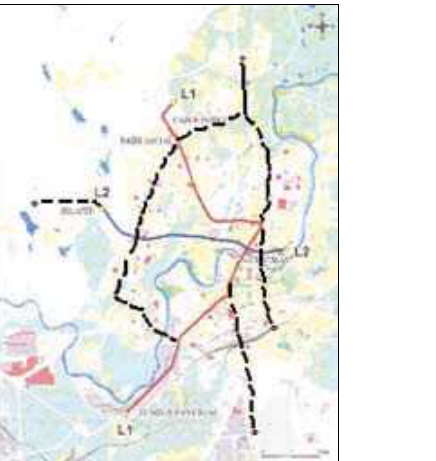
Fig. 3. Modern tram lines, 2002. ME “Vilniaus planas“,